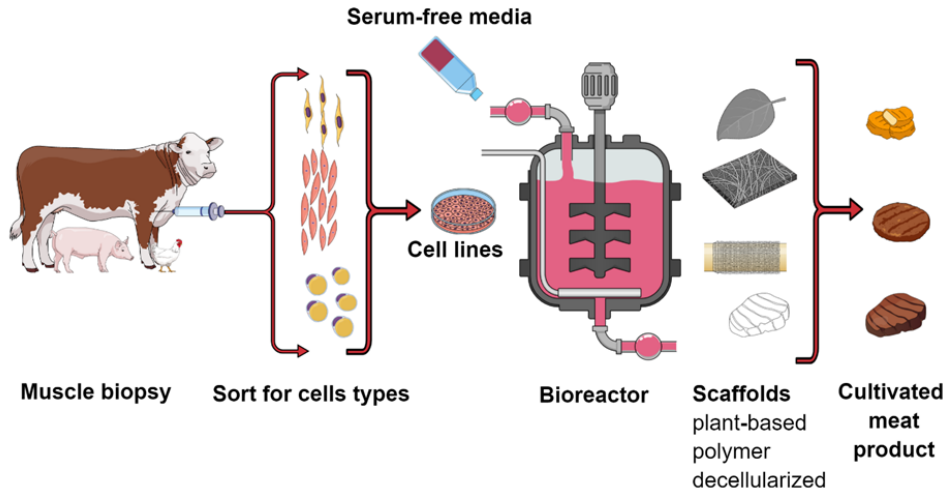
Figure 3. General scheme illustrating the basic steps involved in the production of cultivated meat. 1. Muscle biopsy from selected animals (under anesthesia). 2. Cells selection and cell culture. 3. Har-